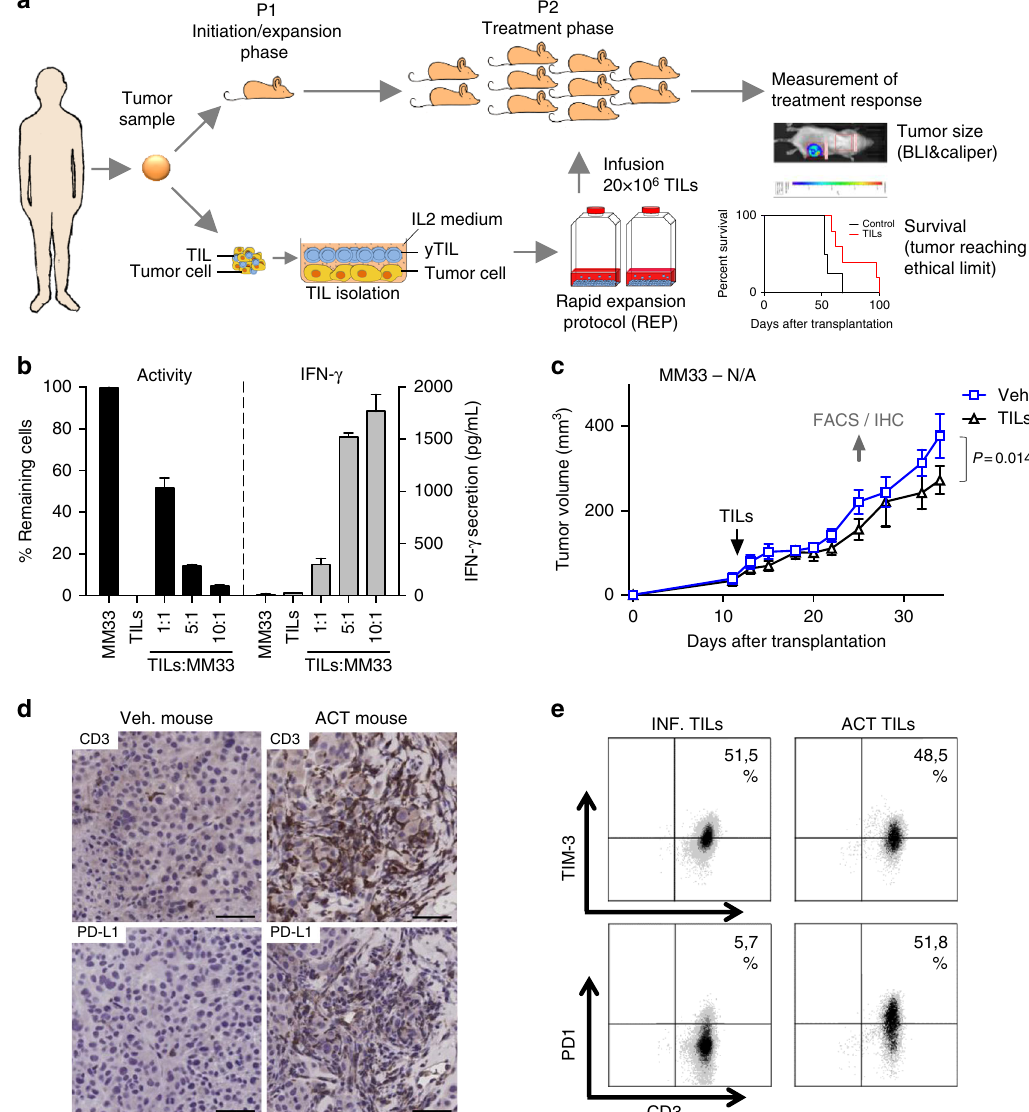
Fig. 1 Effective in vitro cytotoxicity does not result in effective anti-tumoral activity in NOG mice. a Schematic representation of the humanization process (PDXv2.0). b Melanoma cells from patient #33 (MM33) were transduced with a luciferase lentivirus. Cells were plated in a 96-well plate and were mixed with post-REP TILs from the original tumor. Luciferin was added to the media and the viability of the luciferase-expressing tumor cells was measured in a luminometer. The experiment was done in triplicates and the error bar represents ± SEM. c MM33 cells were transplanted into ten NOG mice. 1 week after transplantation, mice were randomized into two groups, one of which received a tail vein injection with autologous TILs. 45,000 U IL-2 was given daily for 3 days following TIL injection and thereafter twice weekly during 3 weeks. Tumor growth was measured using calipers. P -values are from a multiple t -test analysis. d , e When robust progression was noted in all mice, the mice with the slowest and fastest growing tumors in each group were sacri fi ced and the tumors were analyzed by immunohistochemistry ( d , bar = 50 µ m) or fl ow cytometry e for indicated markers. When PD1 expression was observed, anti-PD1 antibody pembroluzimab was given to the mice twice weekly. The experiments shown were performed